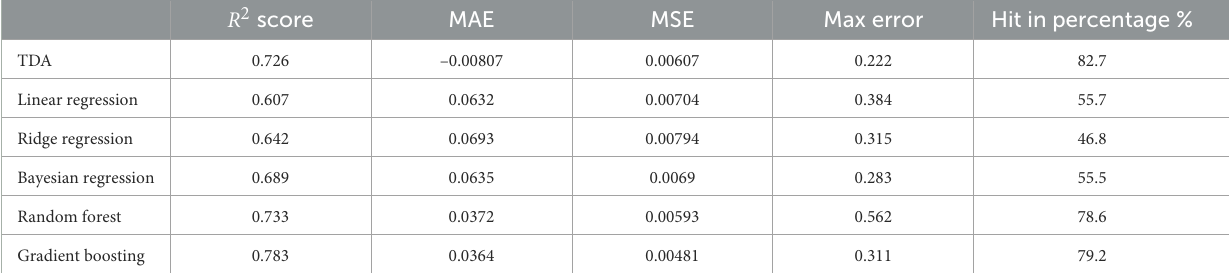
TABLE 6 Comparison between statistics of the TDA method with classical regression